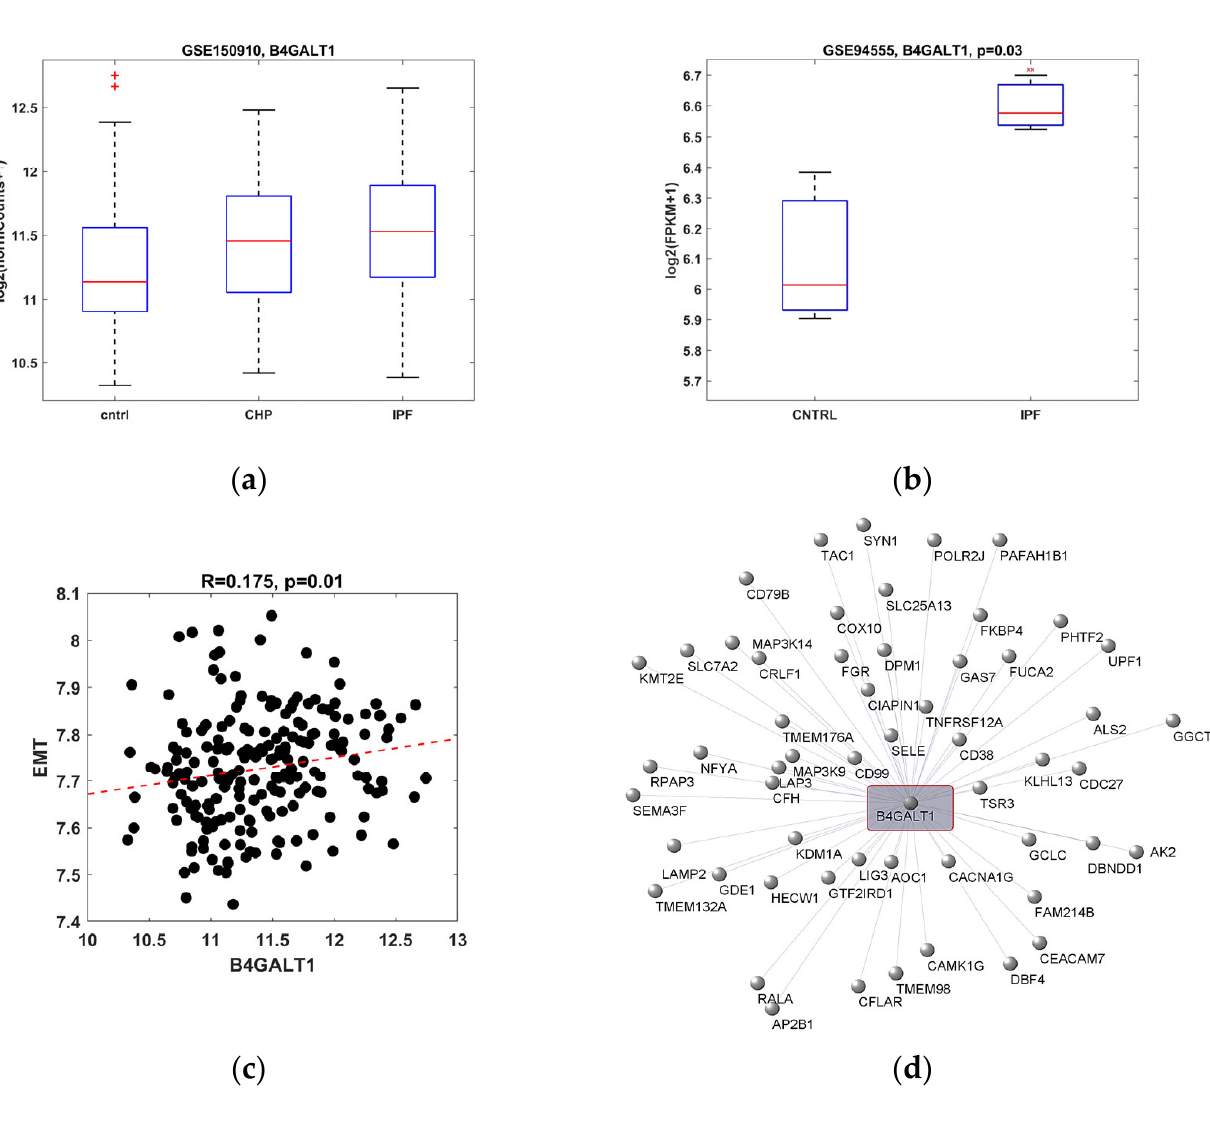
Figure 1. Bioinformatic analysis to evaluate B4GALT1 in silico expression. ( a ) Box plot representing B4GALT1 expression from RNA-seq-based transcriptomic analysis for whole lung tissues from 82 chronic hypersensitivity pneumonitis (CHP), 103 IPF, and 103 control subjects. We observed a statistical significance comparing both CHP and IPF samples to healthy subjects ( p = 7 × 10 − 3 , p = 4.1 × 10 − 5 , respectively) by using the Wilcoxon rank sum test. No difference was revealed between CHP and IPF samples ( p = 0.15). A Kruskal–Wallis test among three groups was also evaluated ( p = 1.2 × 10 − 4 ). Data from the GEO database with access ID GSE150910. ( b ) Box plot representing B4GALT1 expression from scRNA-seq transcriptomic analysis of normal and IPF respiratory epithelial cells obtained from peripheral lung of controls (n = 3) and IPF patients (n = 3), respectively. Statistical significance was assessed by Student’s t -test. Data from GEO database with access ID GSE94555. ( c ) Scatter plot of Pearson’s correlation between B4GALT1 expression and the mean expression of HALLMARK_EPITHELIAL_MESENCHYMAL_ TRANSITION genes. Data from GEO database with access ID GSE150910. ( d ) Graphical network analysis obtained by Pearson’s correlation between B4GALT1 and 55 positive correlated genes involved in the EMT pathway. All together, the results of such in silico analysis indicated that B4GALT1 RNAs’ expression is upregulated in both tissue samples and cell cultures from patients with IPF and it is associated with EMT gene network. These results suggest a possible role of this gene as a biomarker of lung